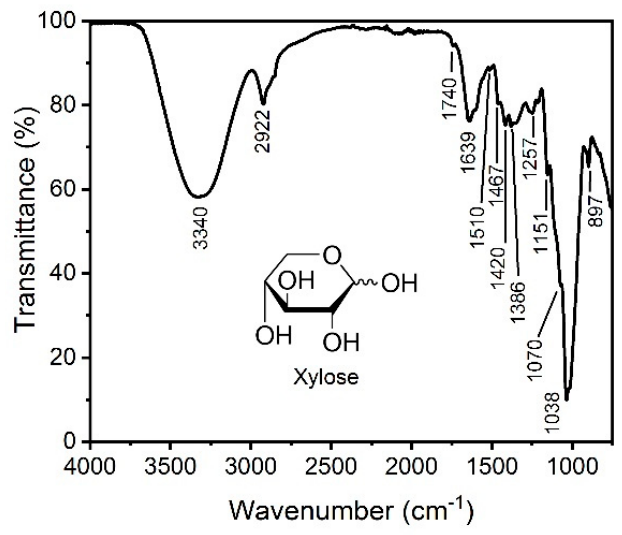
Figure 1. FTIR spectrum of extracted hemicelluloses from sugarcane bagasse.